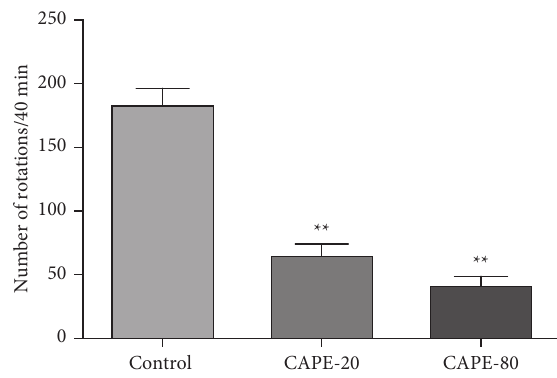
Figure 5: 0.25mg/kg apomorphine-induced contralateral rotations in 40min for control (6-OHDA-induced lesion rats), CAPE 20, and CAPE 80 groups. Control group, n � 7; CAPE 20 group, n � 9; CAPE 80 group, n � 8. ∗∗ p < 0 . 01 versus control. Table 1: Number of neurons 8days after 6-OHDA injection for control, CAPE 20, and CAPE 80 groups. ∗ p < 0 . 05, # p < 0 . 001 (versus control), † p < 0 . 001 (versus CAPE 20 group).